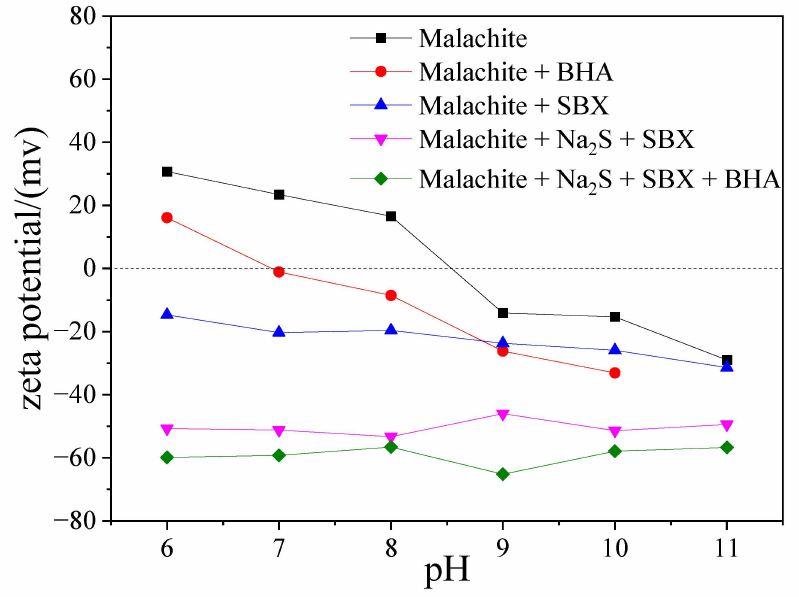
Figure 5. Zeta potential of malachite before and after the treatment with BHA, SBX, and their mixtures.